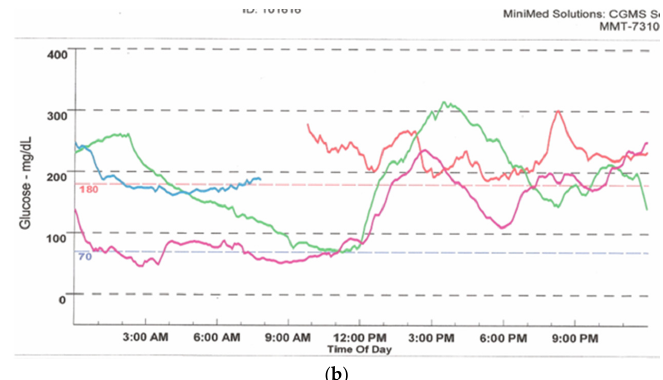
Figure 4. The Medtronic iPro2 Professional Continuous Glucose Monitor ( a ) with its charger, and a Downloaded Tracing showing daily color-coded readings ( b ).